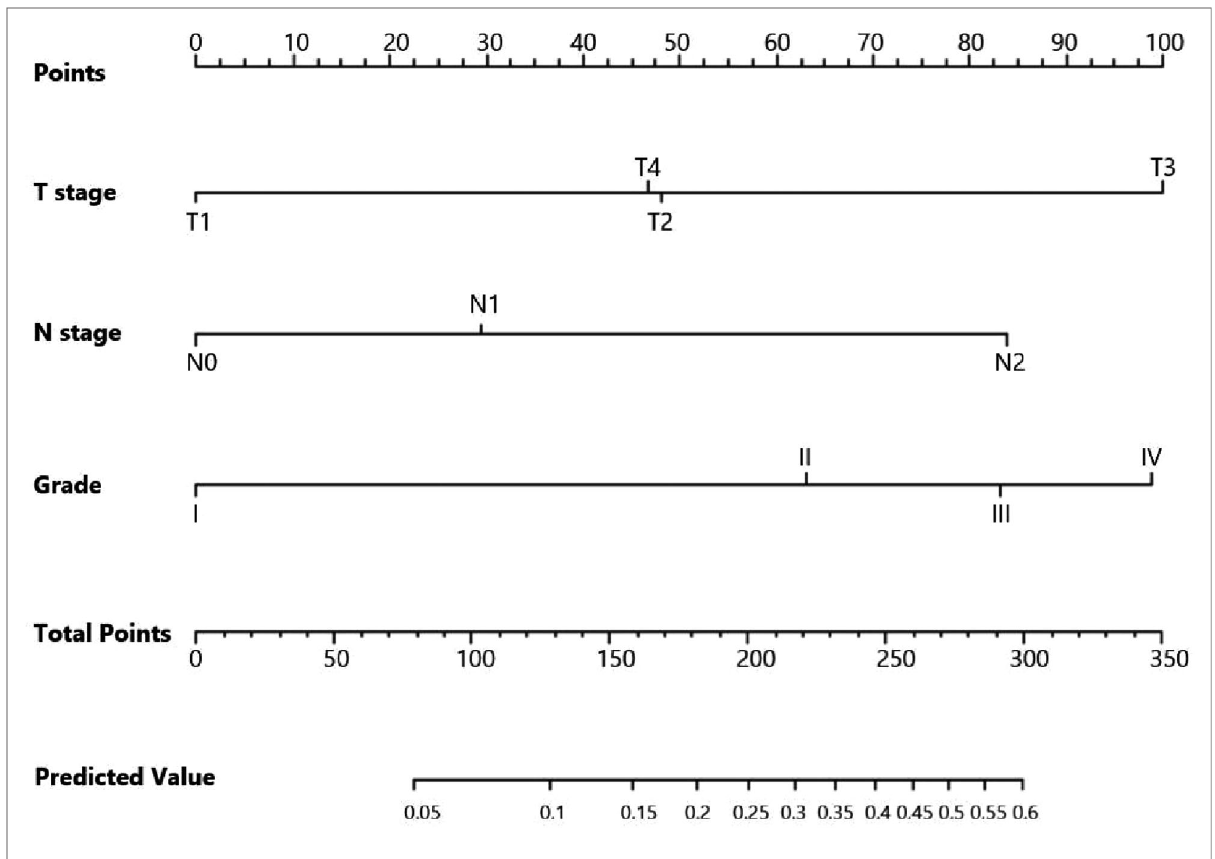
FIGURE 2 Nomogram for predicting liver metastasis in gallbladder cancer